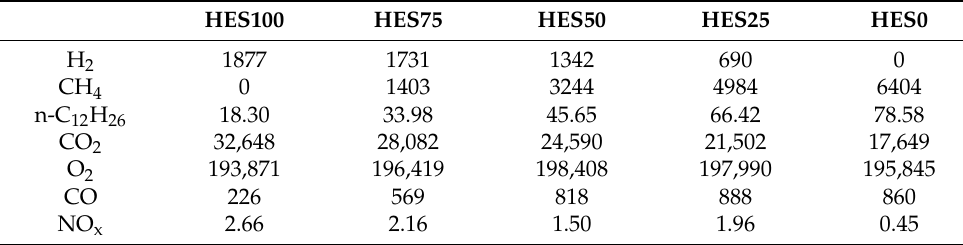
Table 11. Final concentrations of some chemical